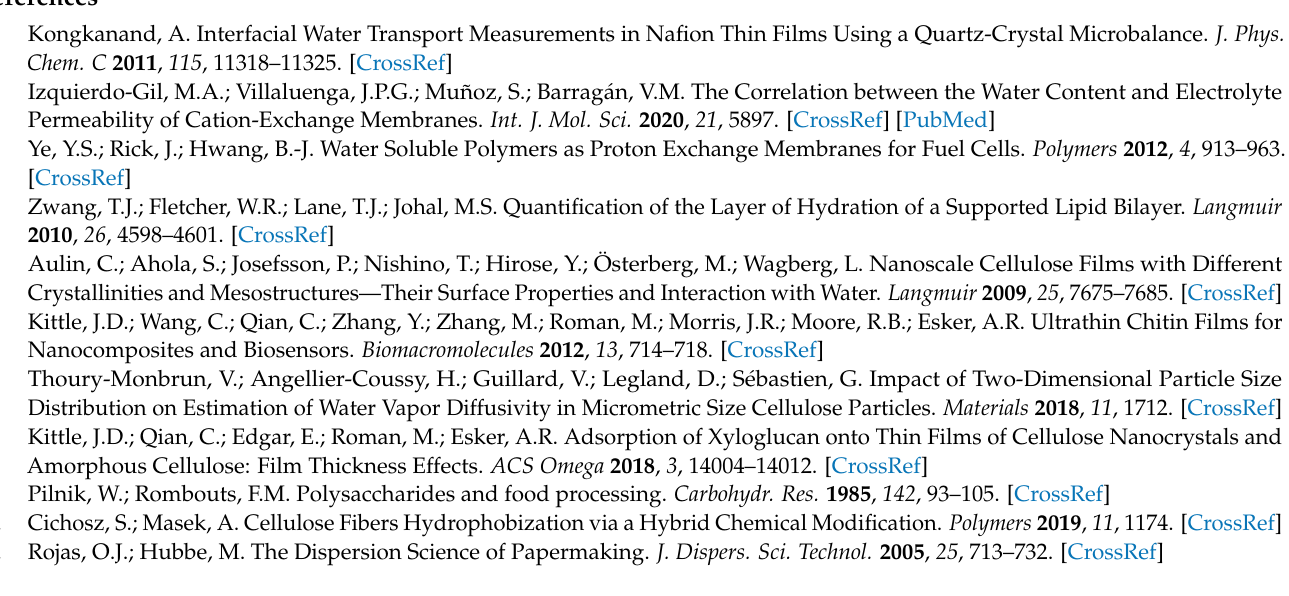
Figure S3: Representative frequency shift data ( n = 5) for the adsorption of a three-layer PAH/PSS film, followed by D 2 O solvent exchange. Figure S4: Representative frequency shift data ( n = 5) for the adsorption of a four-layer PAH/PSS film, followed by D 2 O solvent exchange. Figure S5: Representative frequency shift data ( n = 5) for the adsorption of a five-layer PAH/PSS film, followed by D 2 O solvent exchange. Figure S6: Representative frequency shift data ( n = 5) for the adsorption of a six-layer PAH/PSS film, followed by D 2 O solvent exchange. Figure S7: Representative frequency shift data ( n = 5) for the adsorption of a seven-layer PAH/PSS film, followed by D 2 O solvent exchange. Figure S8: Representative frequency shift data ( n = 5) for the adsorption of an eight-layer PAH/PSS film, followed by D 2 O solvent